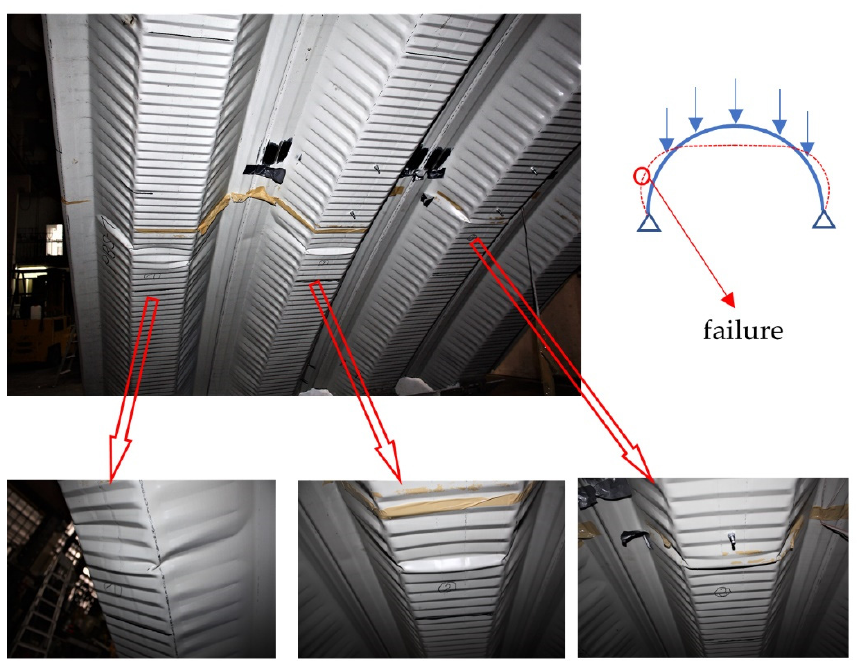
Figure 4. A characteristic mode of profile damage was recorded in the studies on full-size arched structures.